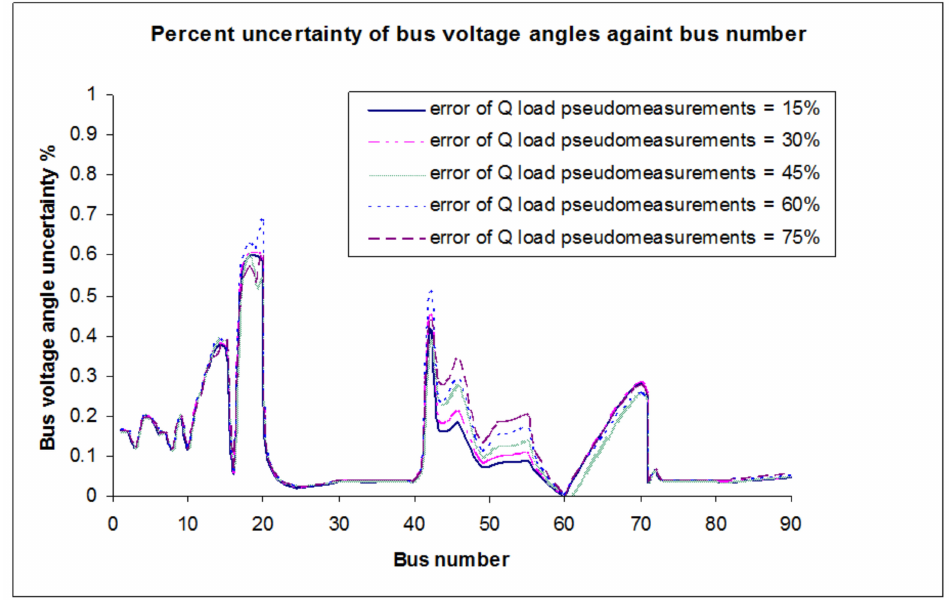
Figure 9. Bus voltage angle uncertainties with regard to errors in reactive load